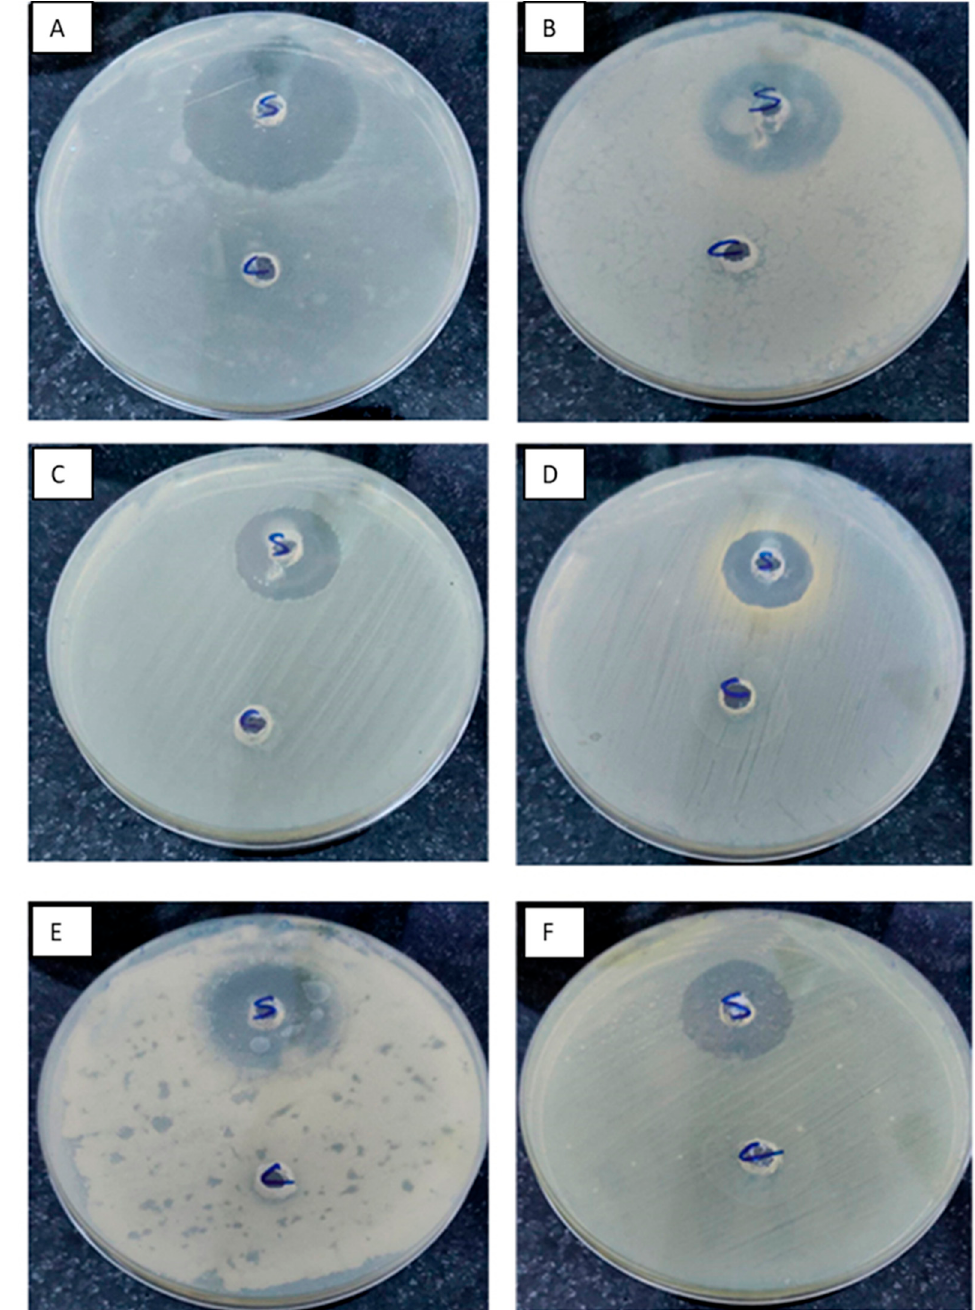
Figure 11. Antimicrobial efficiency of purified T. funiculosus strain CBS 129594 chitinase against Pseudomonas aeruginosa ( A ), Escherichia coli ( B ), Bacillus subtilis ( C ), Staphylococcus aureus ( D ), Aspergillus niger ( E ), and Candida albicans ( F ).